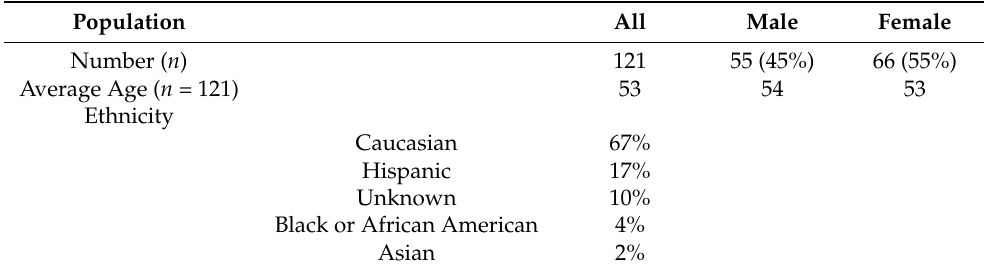
Table 3. Subject demographics for Study 1.